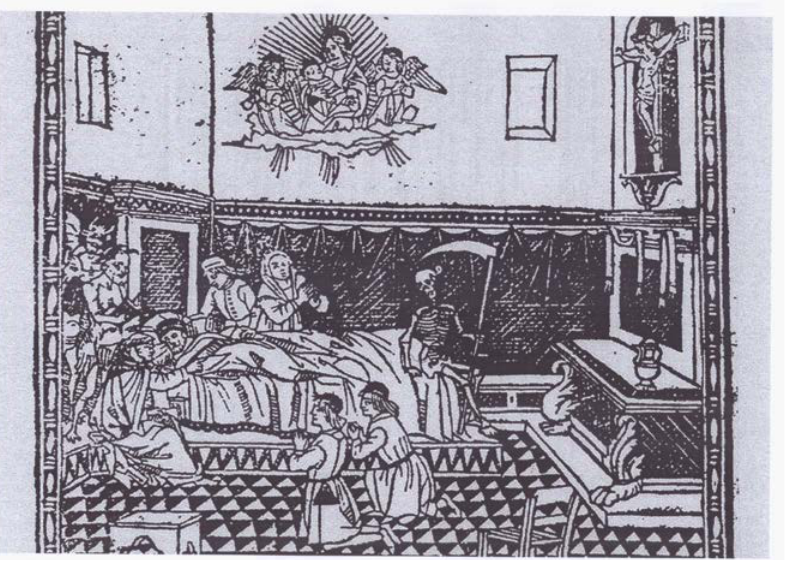
Figure 7 – Girolamo Savonarola, Predica dell’arte del Bene morire , s.n.t. [but Firenze, Bartolomeo de’ Libri, after november 2, 1496), f. 14r (BNCF, Cust. E 6). By permission of Ministero per i beni e le attività culturali / Biblioteca Nazionale Centrale.